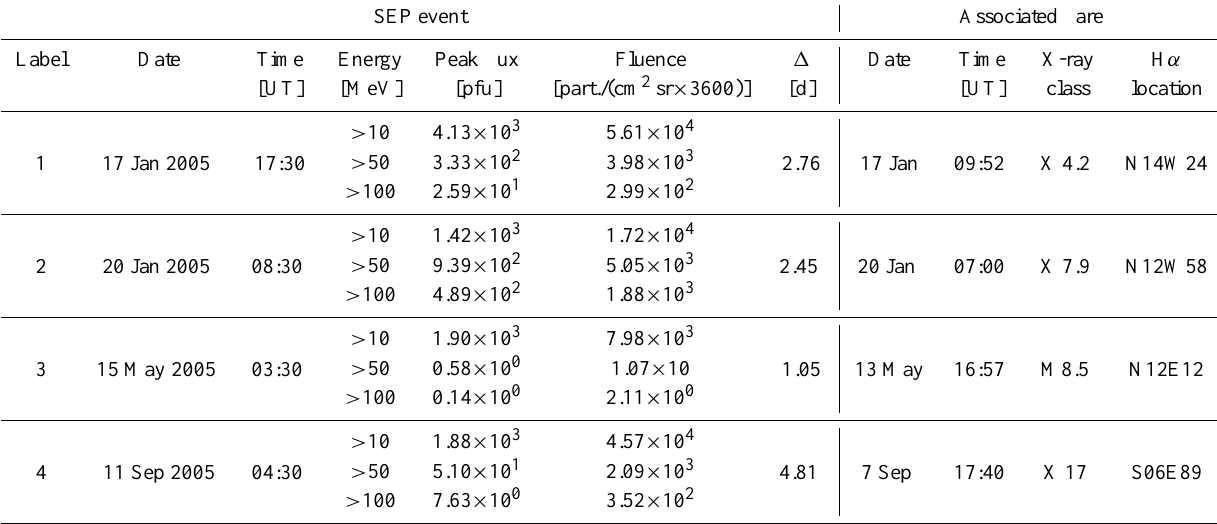
Table 1. Characteristic parameters for the considered SEP events (see the text for details). Date and Time for each SEP event refer to the maximum flux value at >